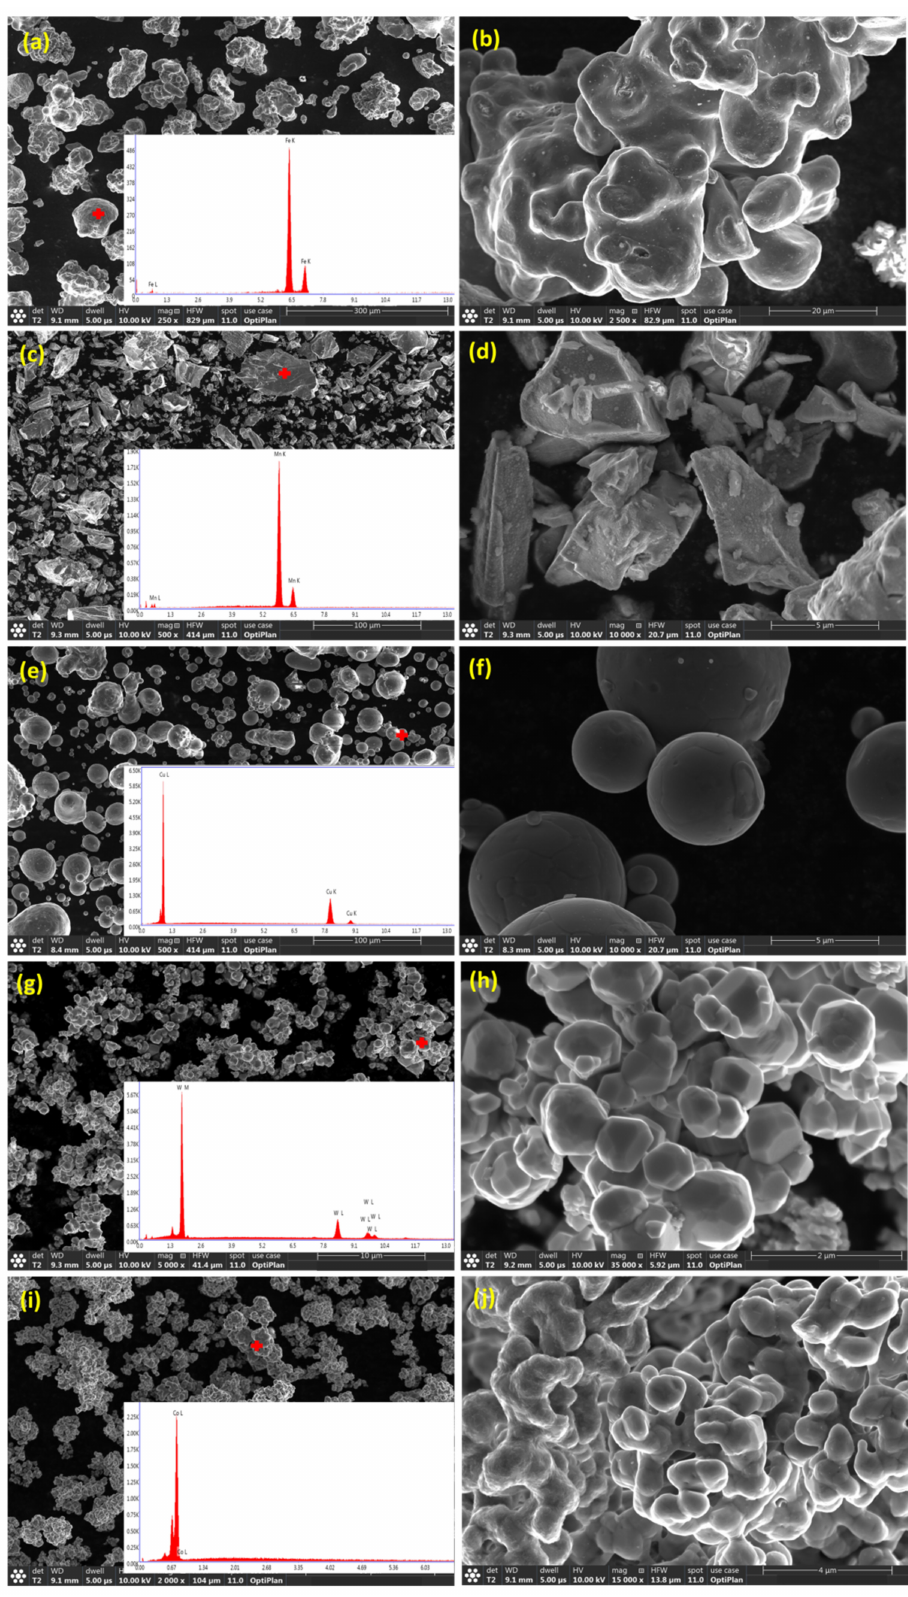
Figure 2. SE images of the as-received powders morphology at low (left) and high magnification (right): ( a , b ) Fe particles; ( c , d ) Mn powders; ( e , f ) Cu powders; ( g , h ) W powders; and ( i , j ) Co powders. The insets at the low magnification images show the EDS spectrum of the corresponding